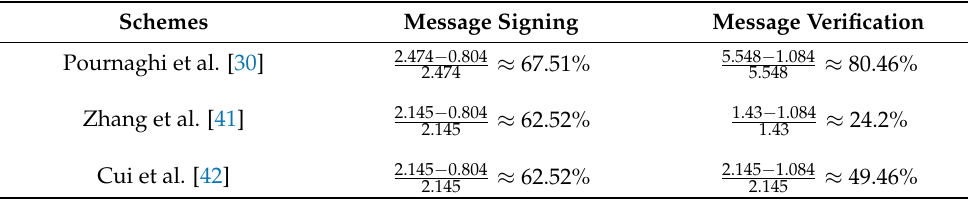
Table 3. Improvement of the Proposed CM-CPPA Over Three CPPA schemes.